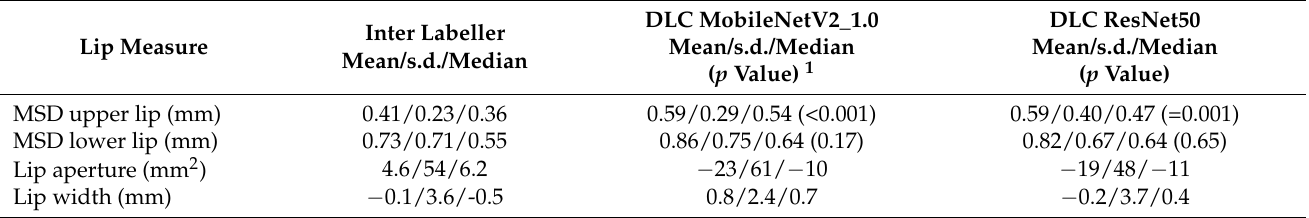
Table 8. MSD, aperture difference, and width difference comparing hand labels to DLC (Mo-